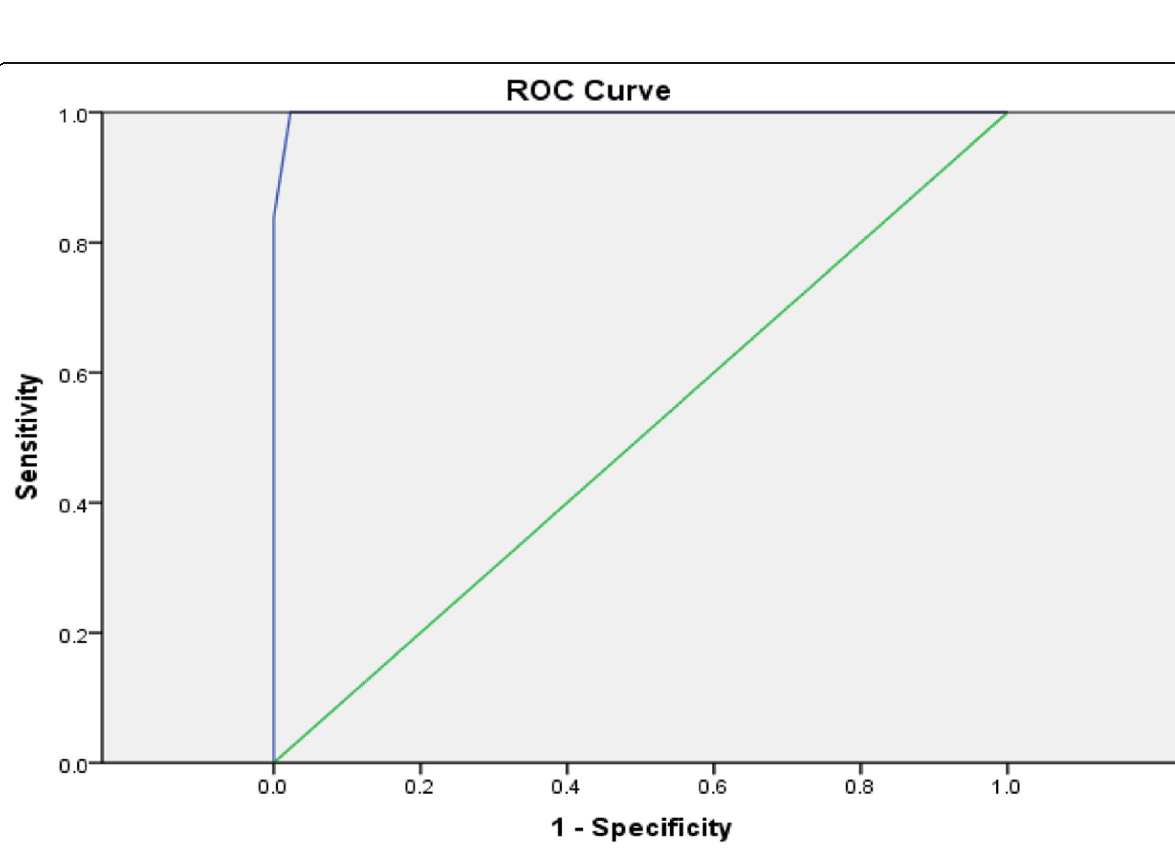
Fig. 3 The receiver operator curve (ROC) of the predictability of thorax trauma severity score (TTSS) with area under the curve equals